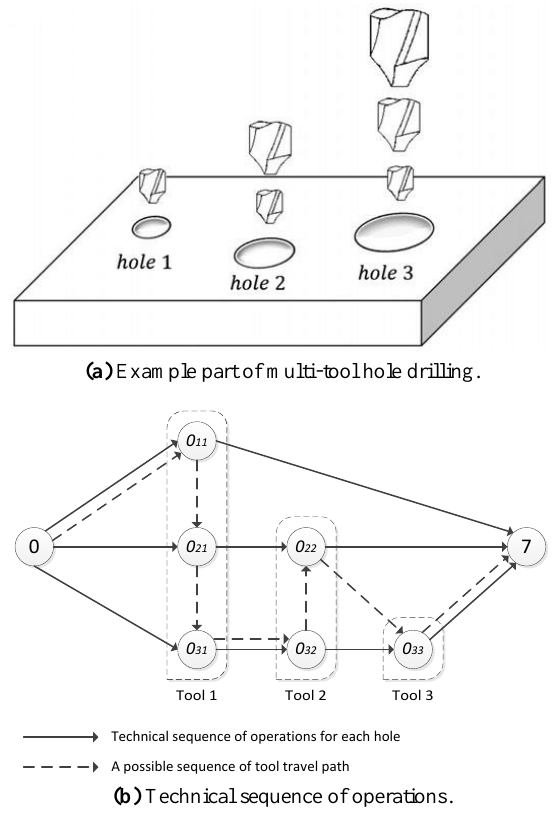
Figure 2. Example for the MTHDPOP-PC [24]. Table 1. Sequence of operations for illustrative example. Hole Tool